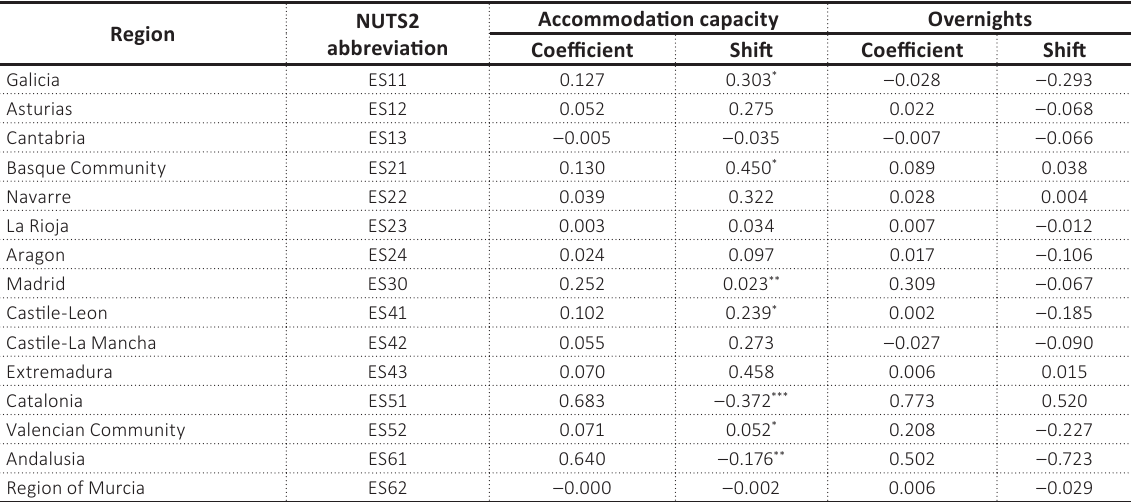
Table 4. Mainland Spain for PLS coefficients of accommodation capacity vs. overnights and